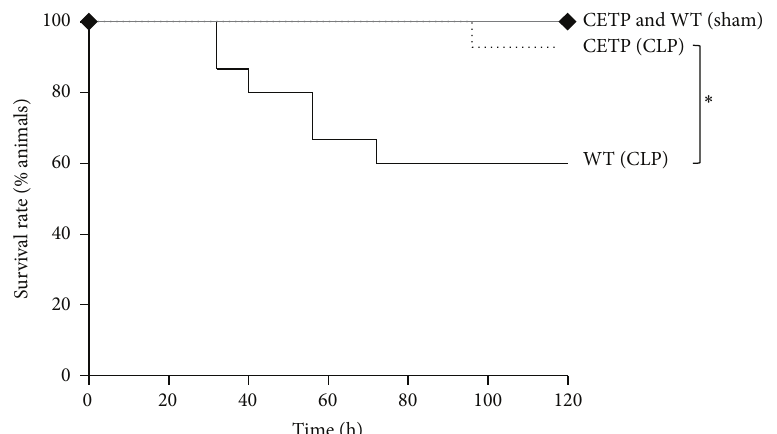
Figure 1: Human CETP expressing mice are more resistant to polymicrobial sepsis than wild type mice. CETP and WT mice submitted to CLP and control mice were sham-operated on ( 𝑛 = 8 ). Survival rate study of mice monitored every 8 hours for 5 days after CLP. ∗ 𝑝 = 0.0267 by a log-rank test between CLP groups. Mortality rate in the sham group did not change.